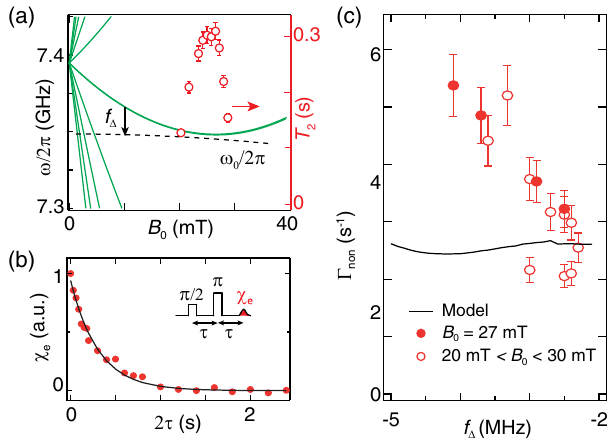
FIG. 6. Nonmagnetic noise characterization at CT in Res1. (a) Calculated spin transition frequencies (green lines), mea- sured resonator frequency (dashed line, left axis), and measured coherence time T 2 (symbols, right axis) as a function of B 0 . (b) Echo integral χ as a function of the delay 2 τ between the π = 2 e pulse and the echo. Red dots are data, and the solid line is an exponential fit yielding a coherence time T 2 ¼ 300 ms. Magni- tude detection is used to circumvent phase noise from the measurement setup. (c) Echo decay rate Γ as a function of non f Δ . Red dots are measurements at B 0 ¼ 27 mT performed over several runs; red circles are extracted from the data in panel (a). The black solid line is the result of the model described in the main